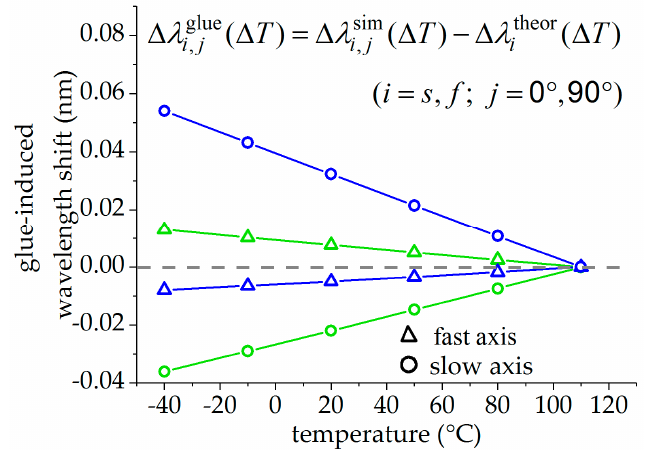
Figure 3. Simulated temperature-dependent deviation of the Bragg wavelength changes of the glued fiber and the theoretical transversal load-free FBG: Green are the values of the FBG in the 90 ◦ -orientation, blue of the FBG in the 0 ◦ -orientation, triangles of the fast and circles of the slow axis.